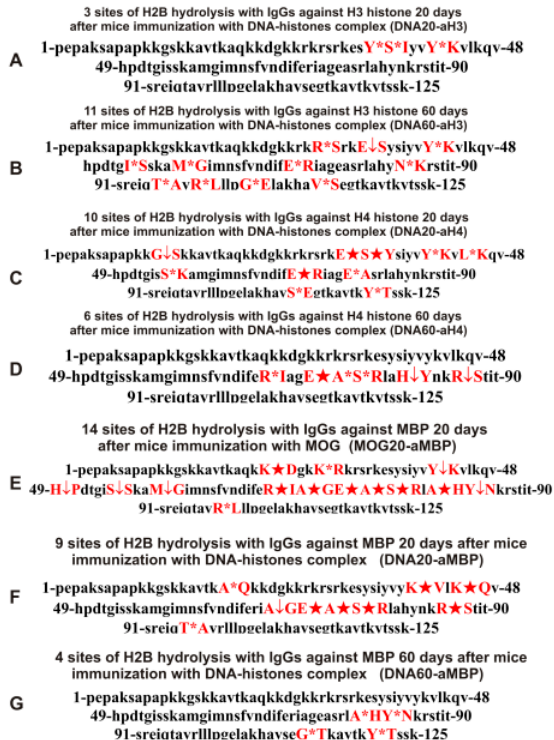
Figure 11. Sites of H2B hydrolysis by IgGs against H3 and H4 histones corresponding to 20 and 60 days after mouse immunization with DNA-histone complex: DNA20-aH3 ( A ), DNA60-aH3 ( B ), DNA20-aH4 ( C ), DNA60-aH4 ( D ), and anti-MBP IgGs 20 days after mouse immunization with MOG-MOG20-aMBP ( E ), as well as 20 and 60 days after mouse immunization with DNA-histone complex DNA20-aMBP ( F ) and DNA60-aMBP ( G ). Major sites of H2A cleavage are shown by stars ( ★ ), moderate sites by arrows ( ↓ ), and minor sites of cleavage by small stars (*). Antibodies against H1 histone corresponding to 3-month-old mice (zero time, Con- aH1-0d) hydrolyzed this histone at 4 sites and at 28 sites after 60 days of spontaneous EAE development (Spont-aH1-60d); for these preparations, only 1 site was the same (Table 2). During the spontaneous development of EAE, the number of histone H2B hydrolysis sites by antibodies against H2A decreased from 9 (Con-aH2A-0d) to 4 (Spont-aH2A-60d) and only 2 sites were the same (Table